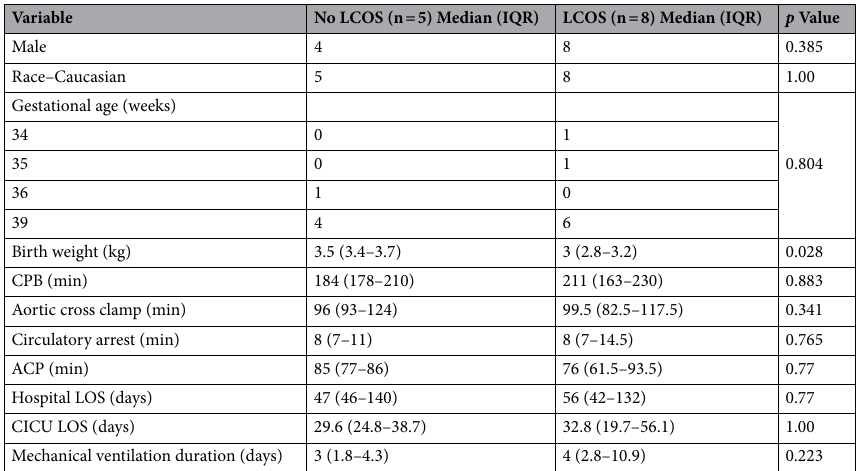
Table 1. Demographic and clinical patient characteristics. LCOS Low cardiac output syndrome, CPB Cardiopulmonary bypass, ACP Antegrade cerebral perfusion, LOS Length of stay.